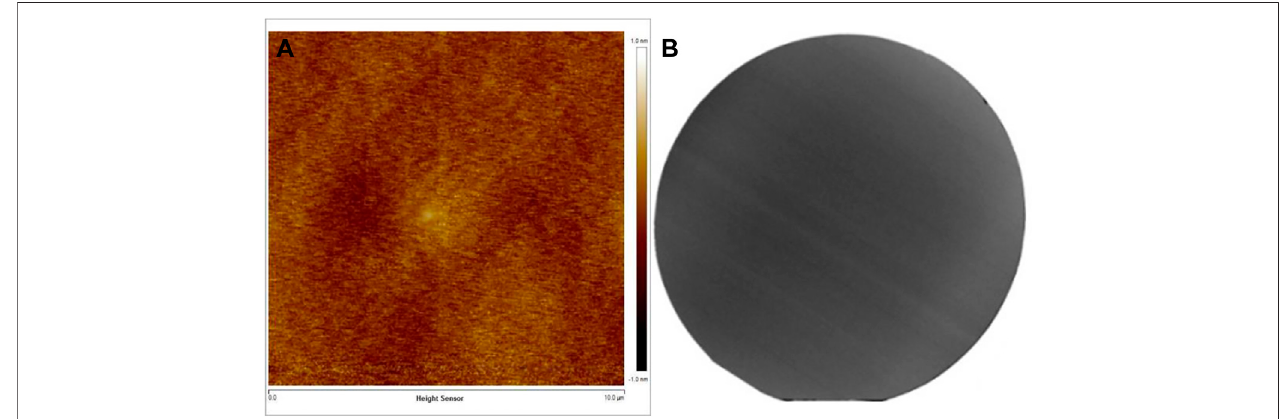
FIGURE 8 | (A) AFM and (B) XRT morphology images of a GaSb surface.